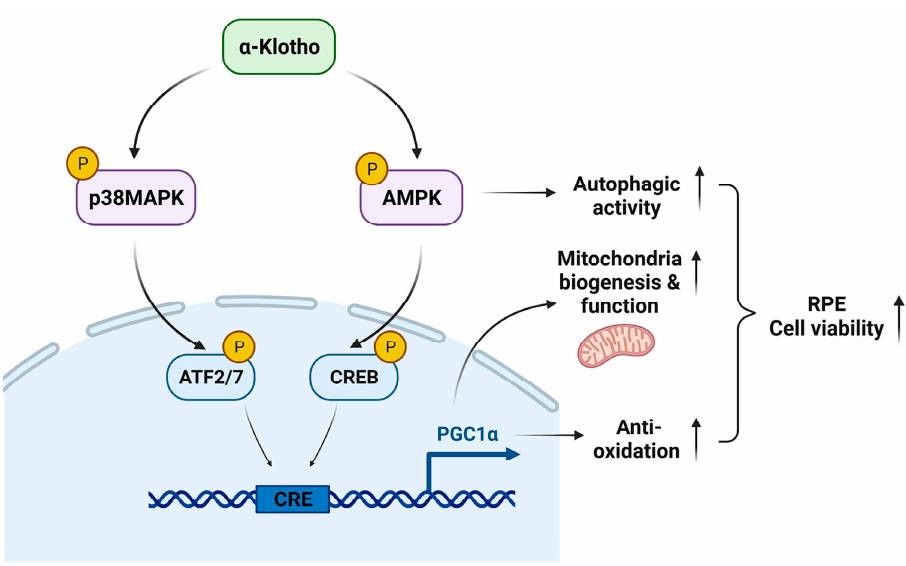
Figure 7. The proposed model of KL action in RPE.